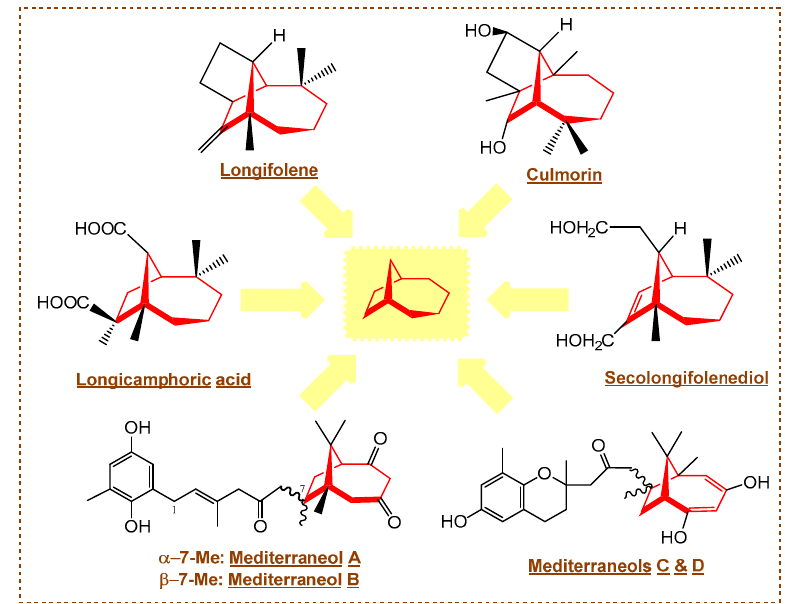
Figure 1. Natural products with the bicyclo[4.2.1]nonane core.